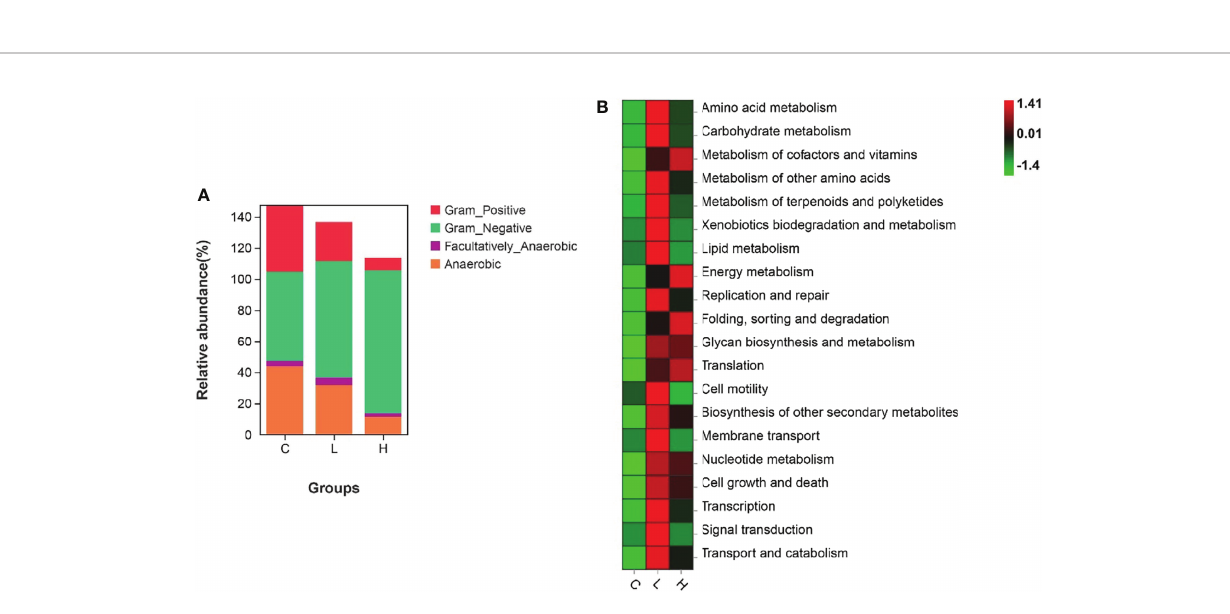
FIGURE 8 | Organism level microbiome phenotypes were predicted by Bugbase (A) . Heat map of functional prediction by PICRUSt (B) .